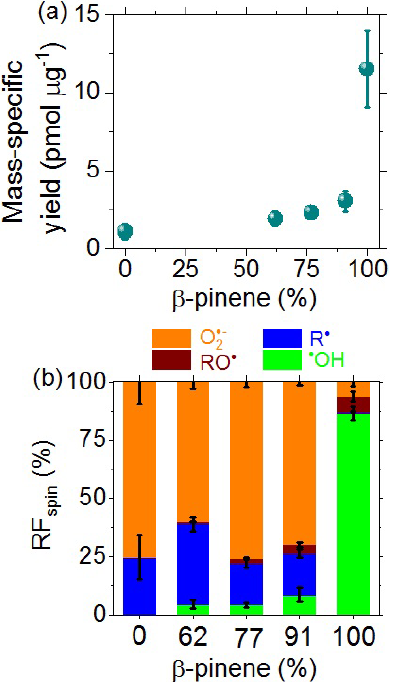
Figure 5. (a) Mass-specific yields and (b) relative fractions (RF spin ) of different types of radicals formed upon the aqueous extraction of laboratory-generated SOA from precursor mixtures of β -pinene and naphthalene plotted against the mass fraction of β -pinene (%) in the precursor mixture. The error bars represent standard errors (4–6 samples per data point).